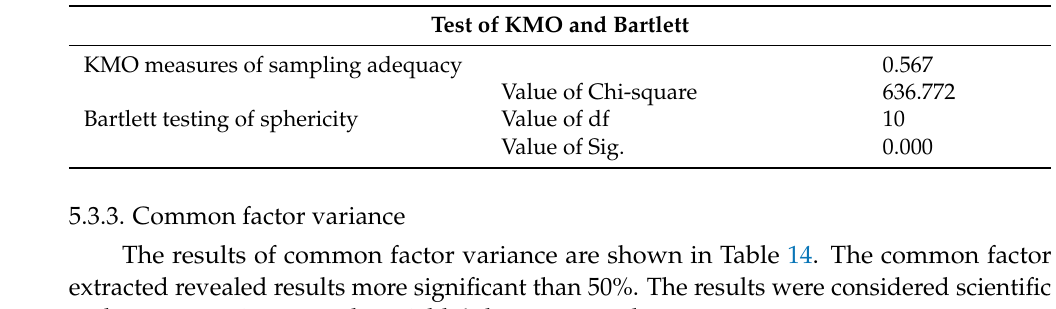
Table 13. Test of KMO and